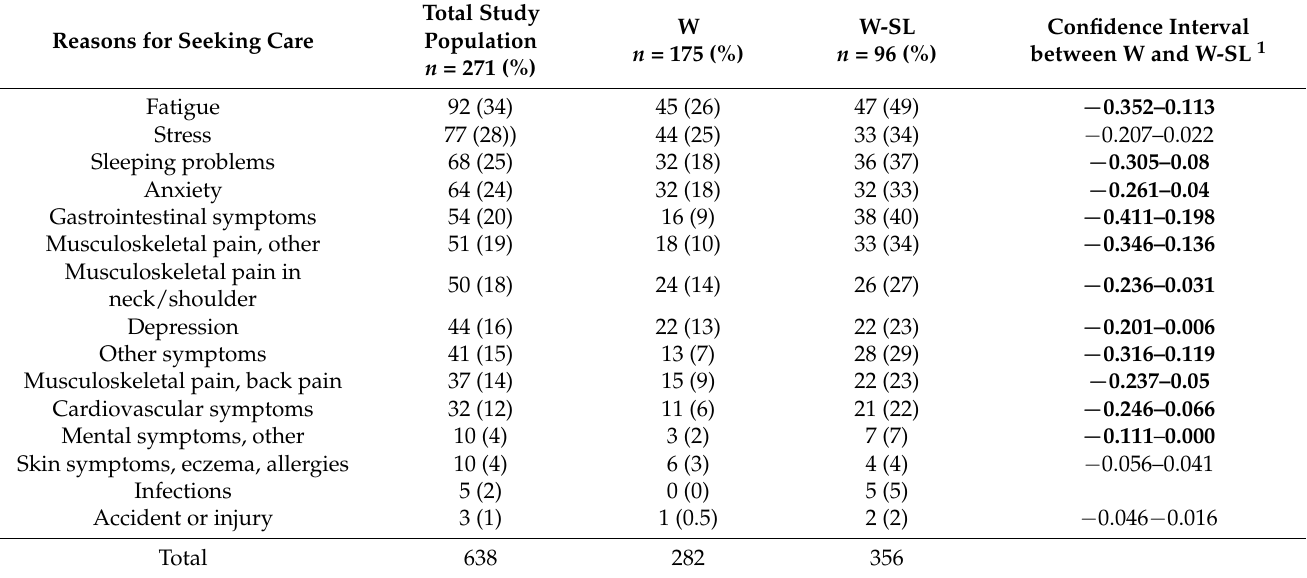
Table 2. Reasons for seeking care, with possible multiple answers, in the total population, n = 271, and in the group of workers (W), n = 175, and the group of workers with sick leave (W-SL), n = 96.